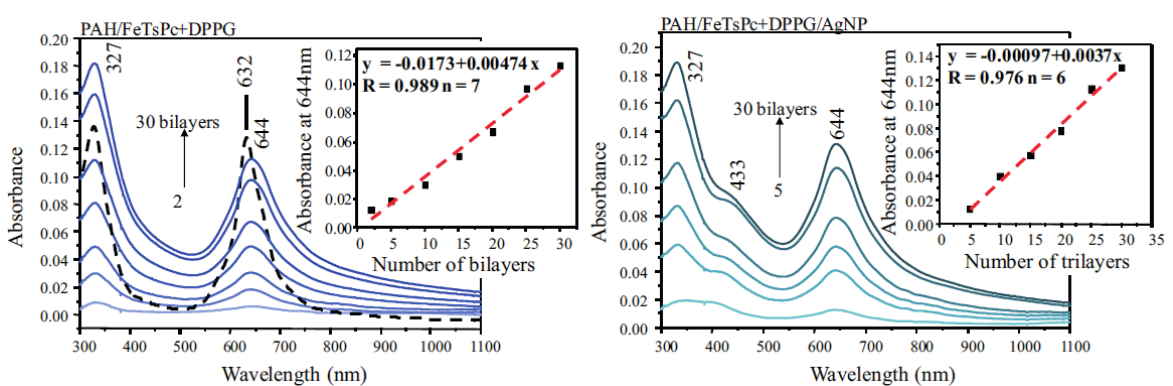
Figure 5 - UV–VIS absorption spectra of (a) PAH/FeTsPc + DPPG LbL fi lms from 2 to 30 bilayers and (b) PAH/FeTsPc + DPPG/ AgNP LbL fi lm from 5 to 30 trilayers. Dashed curve represent the FeTsP + DPPG mixture in aqueous solution. Insets: increases of UV–VIS absorption at 644 nm as a function of the number of (a’) bilayers or (b’) trilayers deposited onto a quartz substrate (Alessio et al.